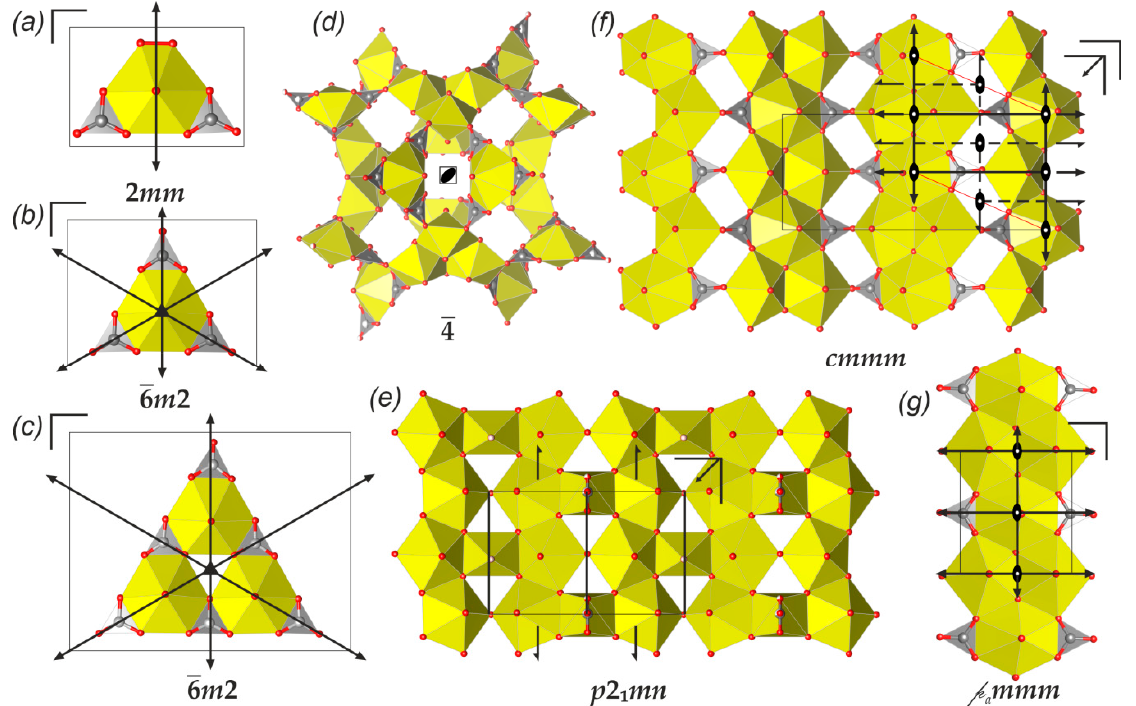
Figure 7. Uranyl carbonate complexes and their highest (topological) symmetry groups. Legend: see Figure 1. See text for details.